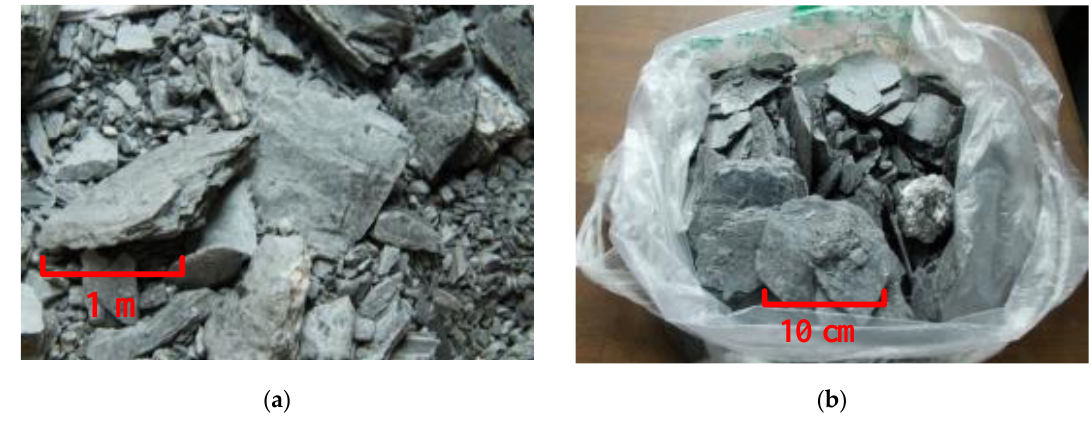
Figure 1. ( a ) Field rock sample; ( b ) carried rock sample.